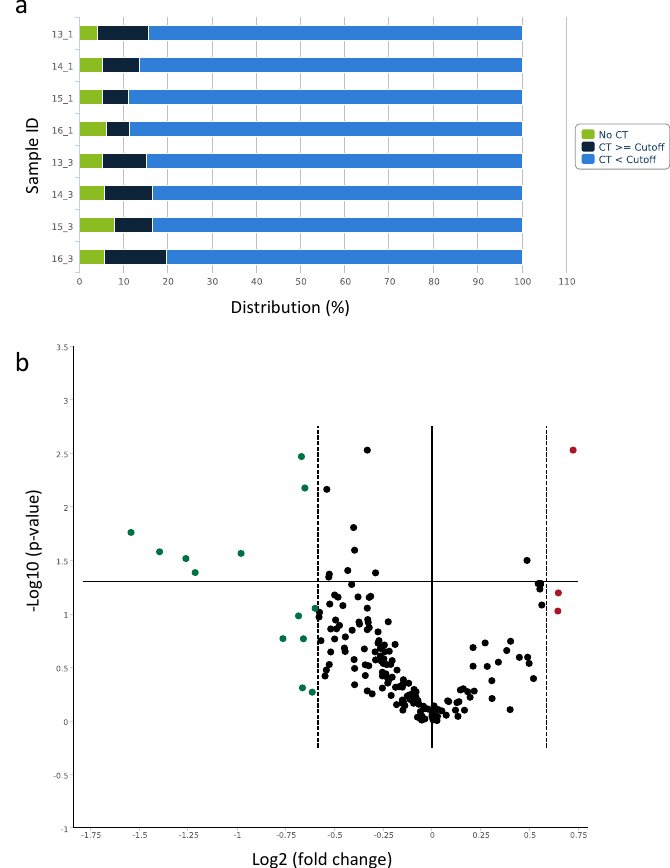
Figure 5. qPCR-based serum / plasma focus panel of circulating miRNAs ( a ) Distribution of C t values for the processed data of each plasma sample. ( b ) Volcano plot of differentially expressed miRNAs pre- and post-LI-BFR training. Data points outside the two dashed lines are up-regulated (red) or down-regulated (green) more than x-fold. Data points above the solid horizontal line have p -values less than 0.05. Table 1. Over-expressed miRNAs (fold regulation values greater than 1.5) and under-expressed miRNAs (fold regulation values less than −1.5) detected in the screen and analyzed in the three different training groups. miRNA ID Fold Change Screen p -Value HI LI-BFR LI hsa-miR-197-3p